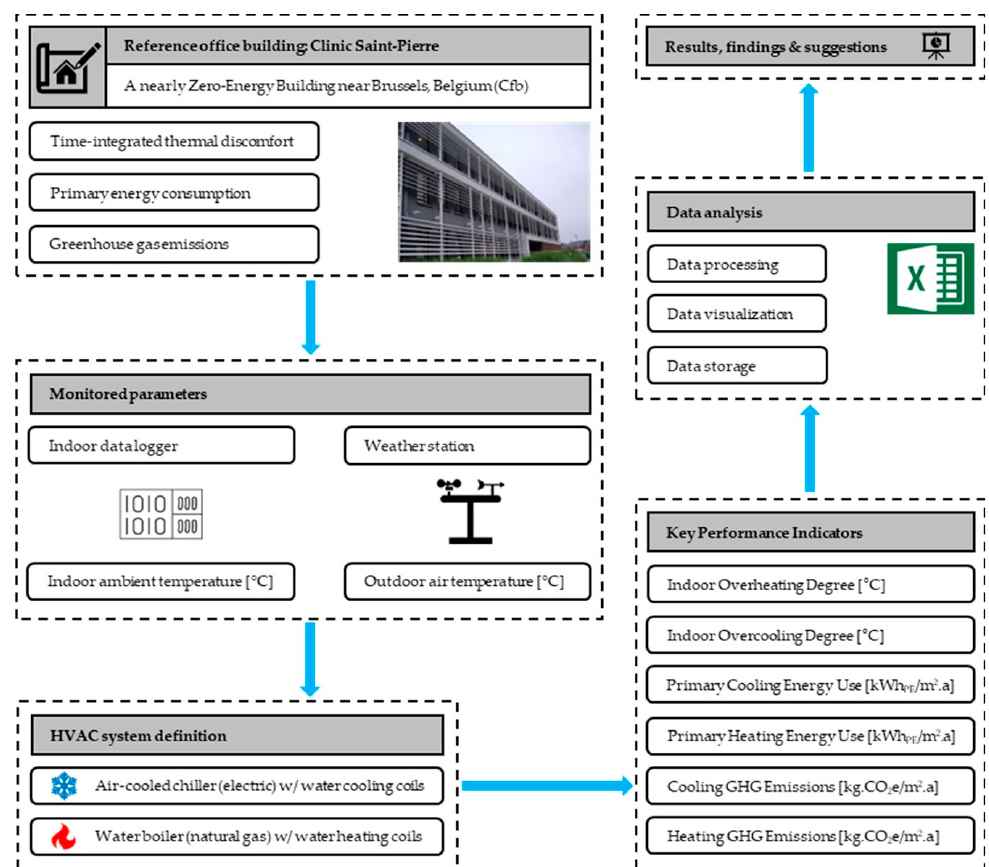
Figure 1. Study conceptual framework.